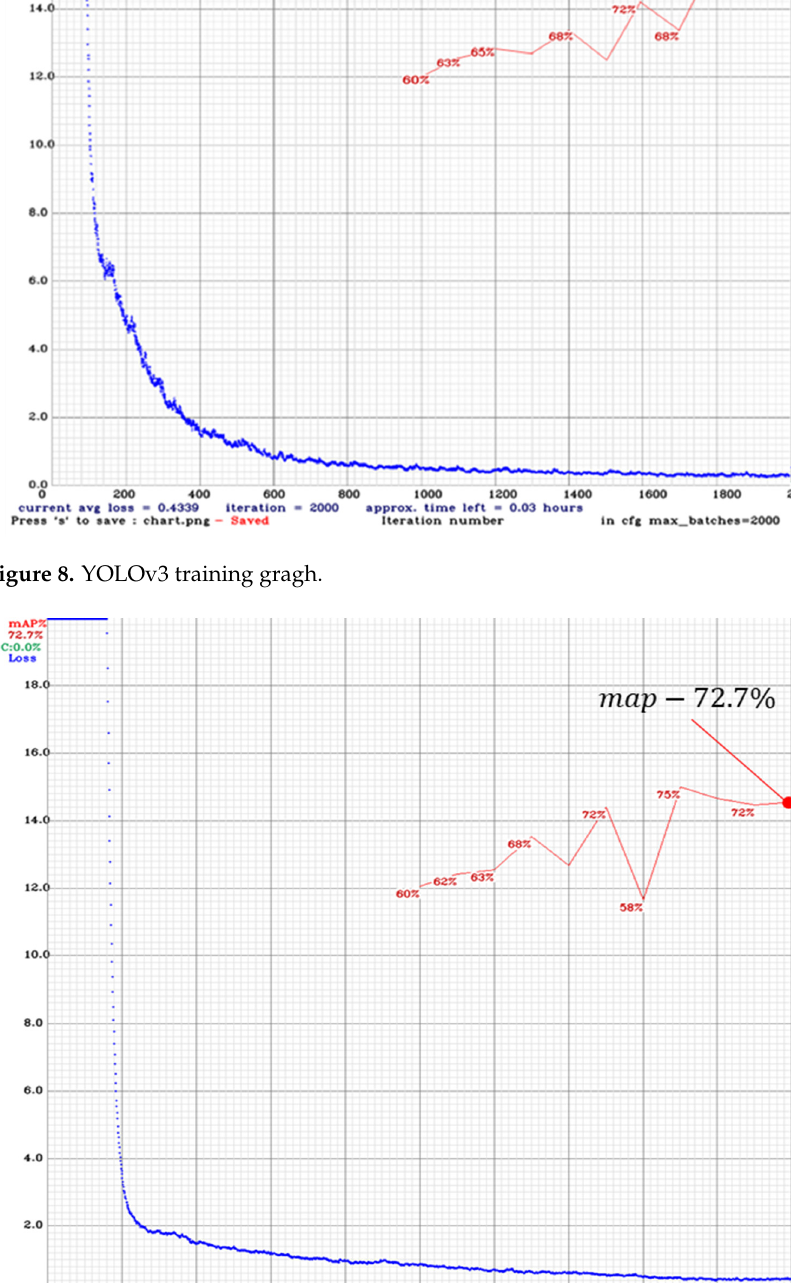
Figure 9. YOLOv4 tiny training gragh.